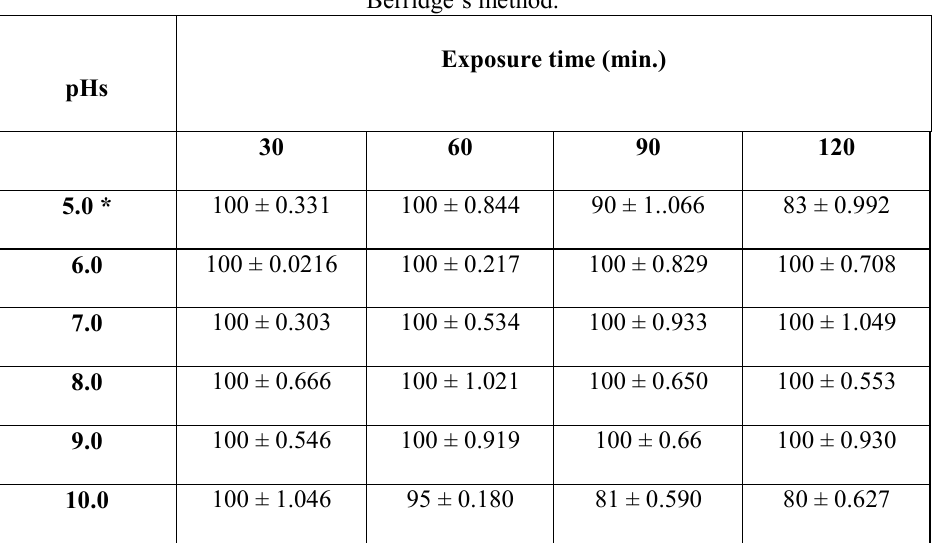
Table 4. reported that blue dextran (1 kD) gave the maximum relative activity (273.8%).